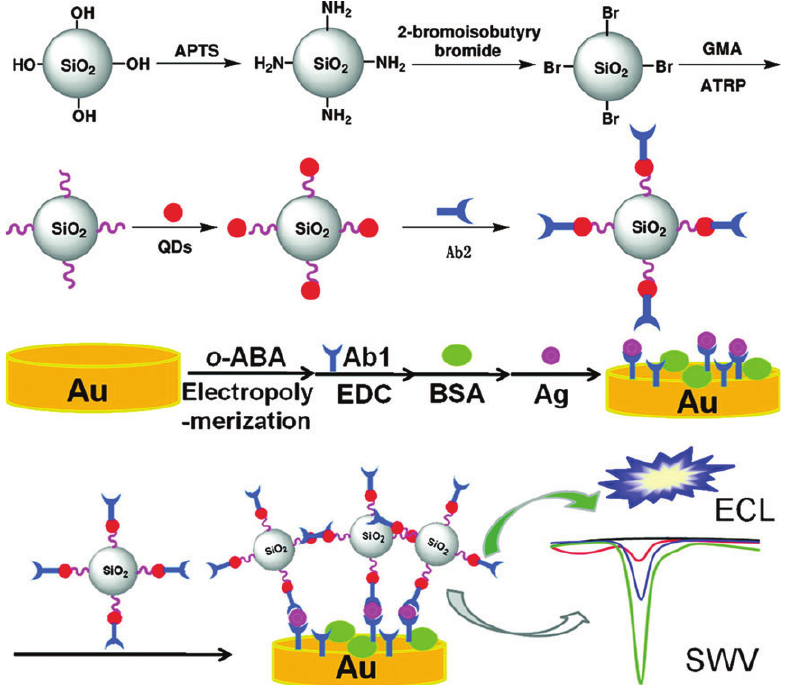
Figure 2 (A) Schematic representation of the preparation of the Si/PGMA/QD/Ab2 label. (B) Schematic representation of the sandwich immunoassay with Si/PGMA/QD/Ab2 as the label. (Reproduced with permission from Yuan et al. 2011